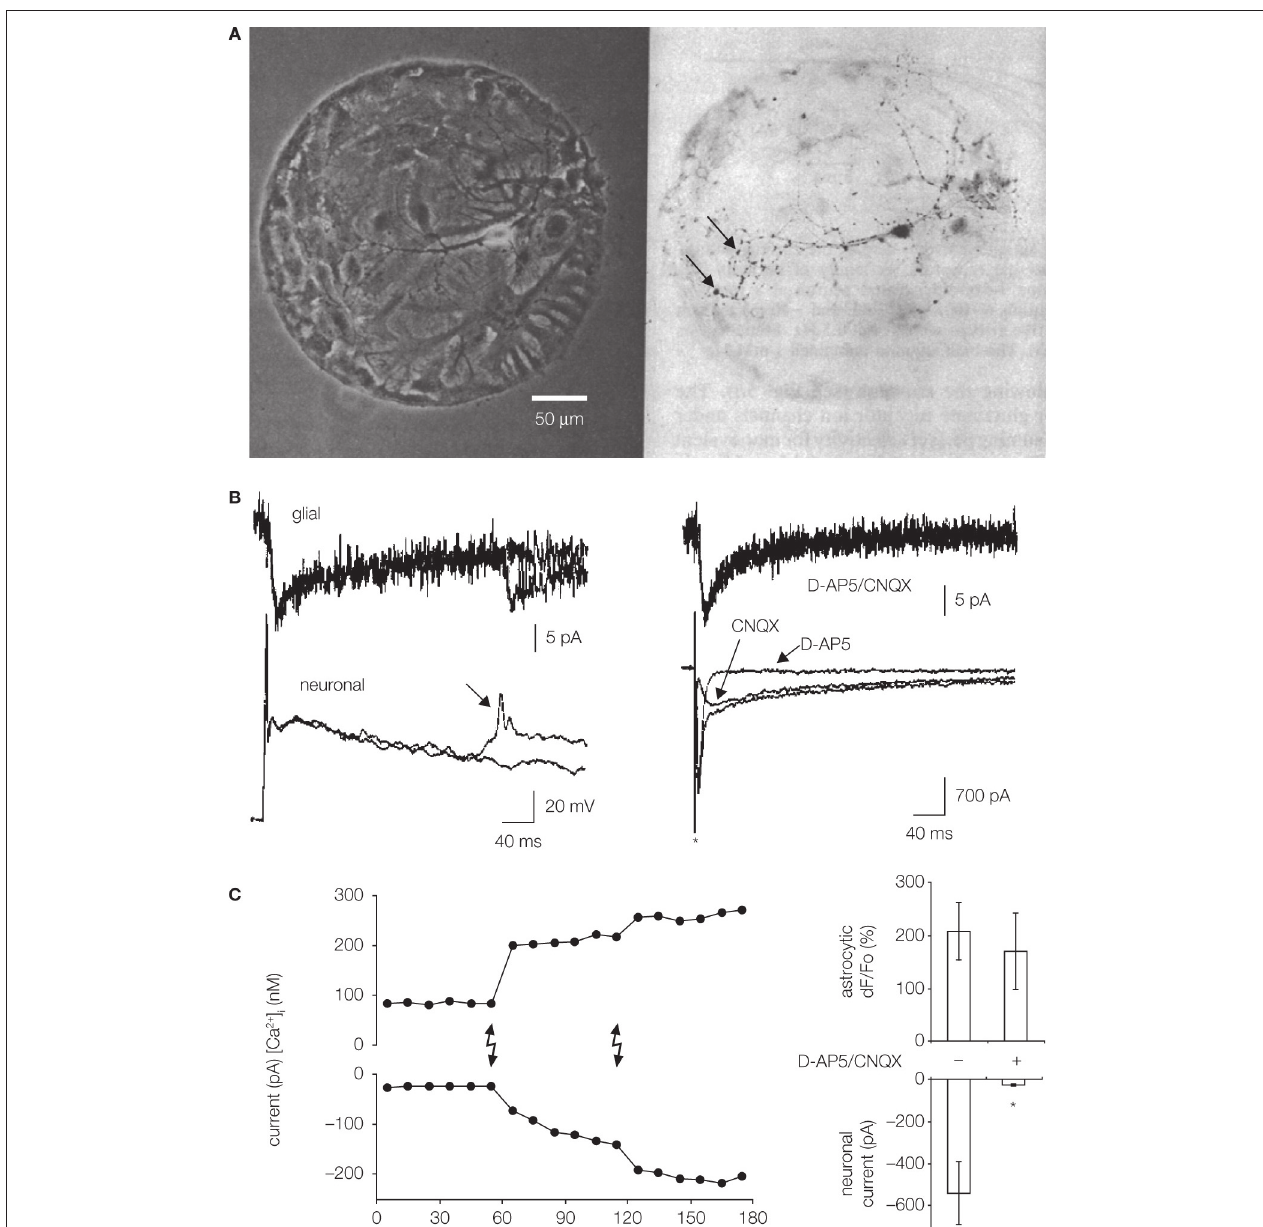
potential (arrow) also causing a glial response. Ionotropic glutamate receptor antagonists ( d -AP5 and CNQX) have no effect on astrocytic currents (right), while their use eliminated different components (slow and fast, respectively) of the autaptic currents in the voltage-clamped neuron. The asterisk indicates artifact due to application of a depolarizing step in the neuron. Modified from Mennerick and Zorumski (1994). (C) Astrocyte-to-neuron signaling. Neurons were plated onto pre-plated purified astrocytes forming microislands. Astrocytes occupying a microisland, loaded with the Ca 2 + indicator and cage, were exposed to UV light (lighting bolts) to cause an increase in astrocytic [Ca 2 + ] Left: Simultaneous electrical recordings from a single neuron, grown on top of astrocytes, indicate that the physiological increase in astrocytic [Ca 2 + ] is sufficient to cause glutamate-mediated SICs in neurons. Right: d -AP5/CNQX significantly (asterisk) attenuated the ability of photolytic Ca 2 + elevations in astrocytes [shown as dF/Fo (%)] to cause neuronal SICs (right). Modified from Parpura and Haydon